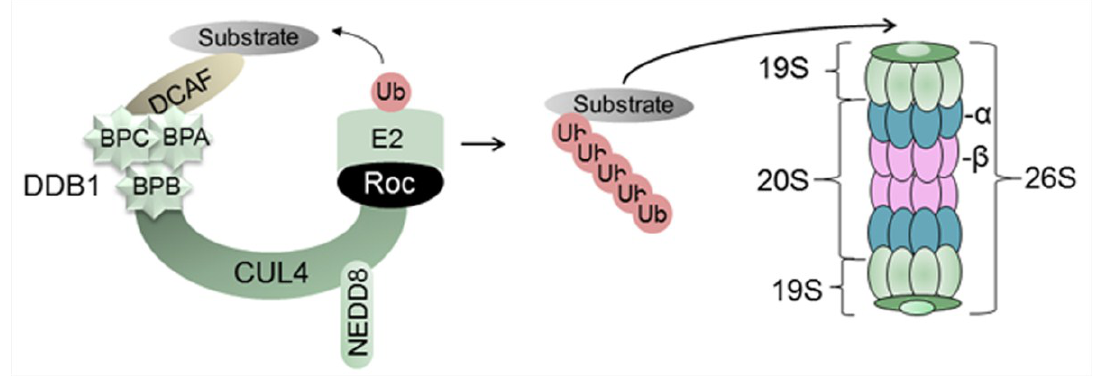
Figure 1. Schematic of the UPS. In the example provided, the E3 ligase consists of the CUL4 scaffold, the DDB1 adaptor protein (folded into three β-propellar, or BP, domains), and the RING protein (Roc) that binds to the E2 enzyme. This complex recruits substrate proteins for ubiquitination and degradation by the 26S proteasome, as described in the